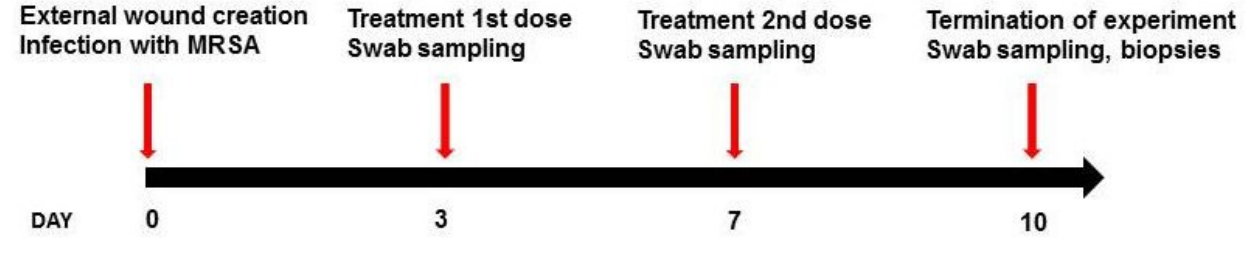
Figure 8. The timeline of the